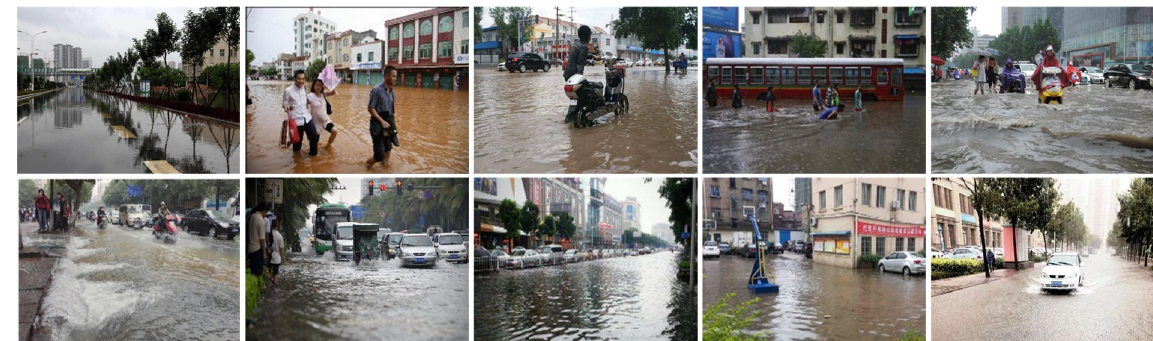
Figure 8. Images of urban streets with fl oods.